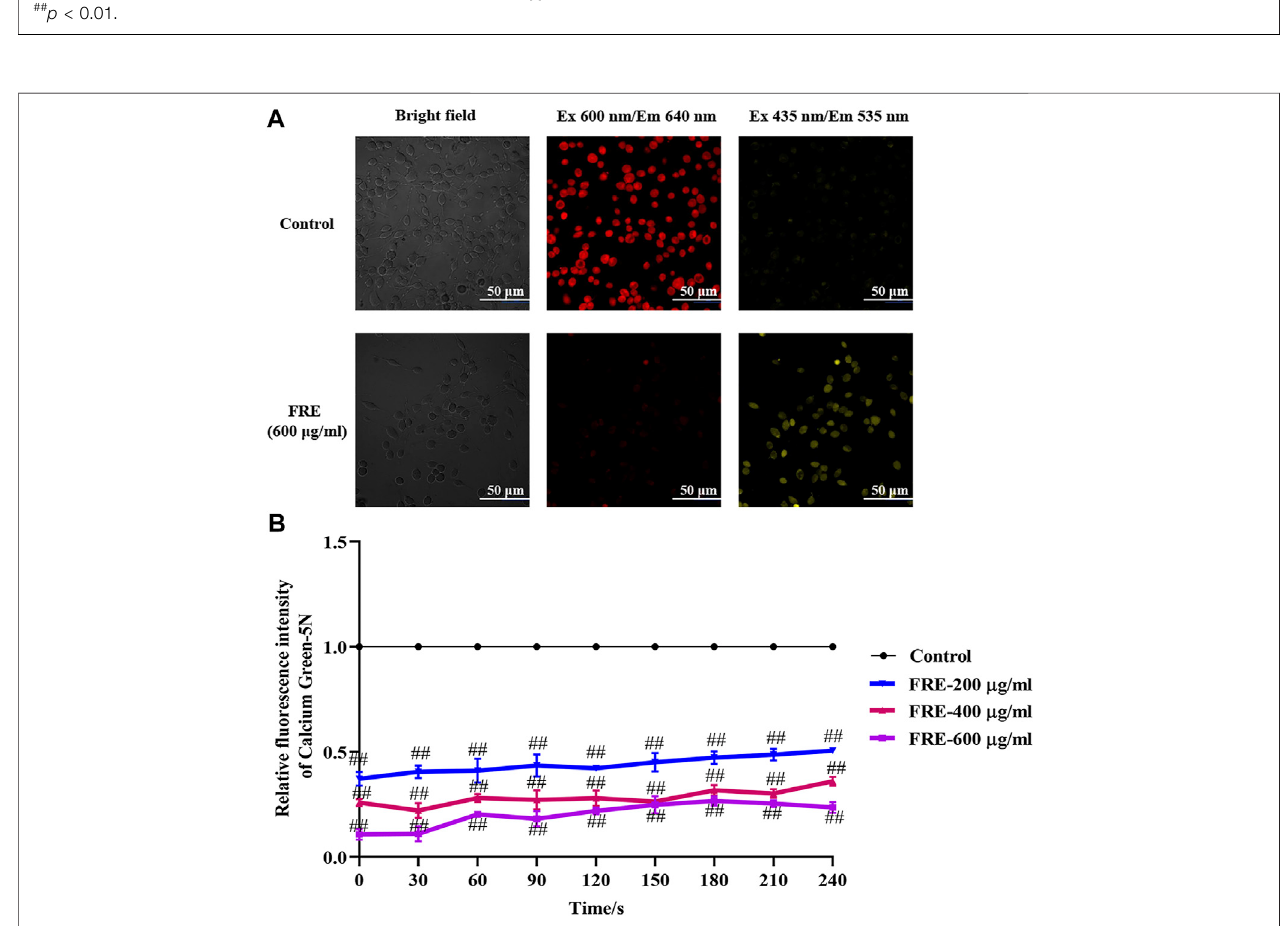
FIGURE 7 | FRE increases Ca 2+ [m] uptake ( n (cid:2) 3 ). (A) Representative images of FRE induced Ca 2+ [c] decrease and Ca 2+ [m] increase in RBL-2H3 cells. Cells were transfected with pcDNA-4mtD3cpv. Forty-eight hours later, cells were then loaded with Cal-630 AM. After removing the dye, cells were treated with FRE (600 μ g/ml) or the equal volume of vehicle (control). The fl uorescent images were immediately taken by a laser confocal fl uorescence microscopy (Nikon A1) using a 60 × oil objective (Cal-630 AM,